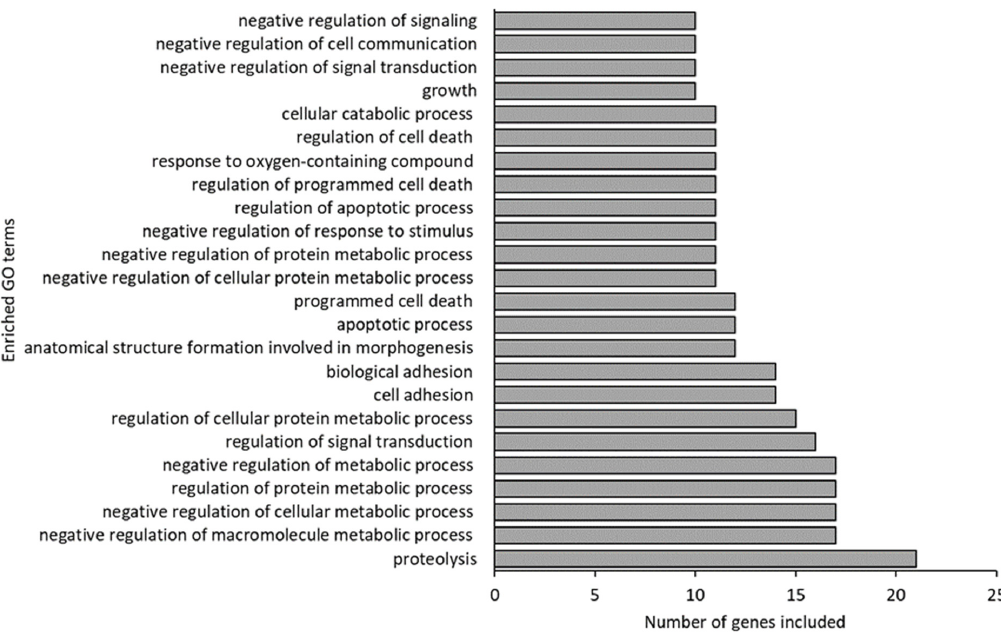
Figure 5. Enriched Gene Ontology (GO) terms (including 10 or more of the 52 input genes) in germ-free fish compared to conventional fish.